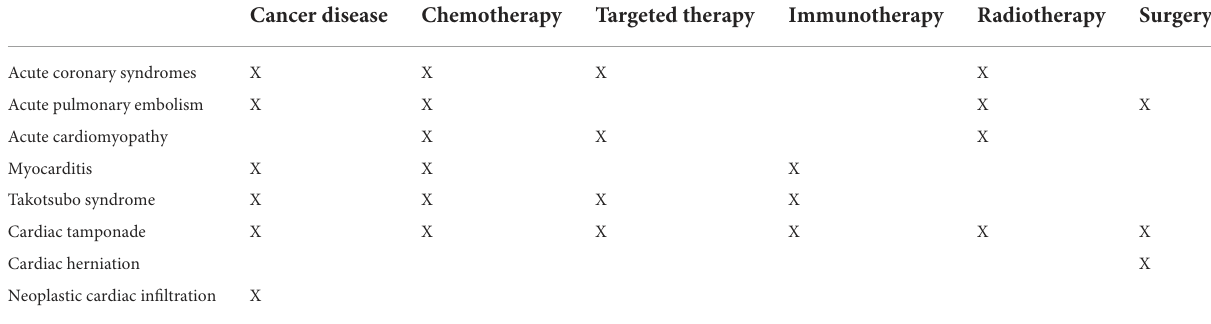
TABLE 5 Main etiologies related to cardiogenic shock in cancer patients. Cancer